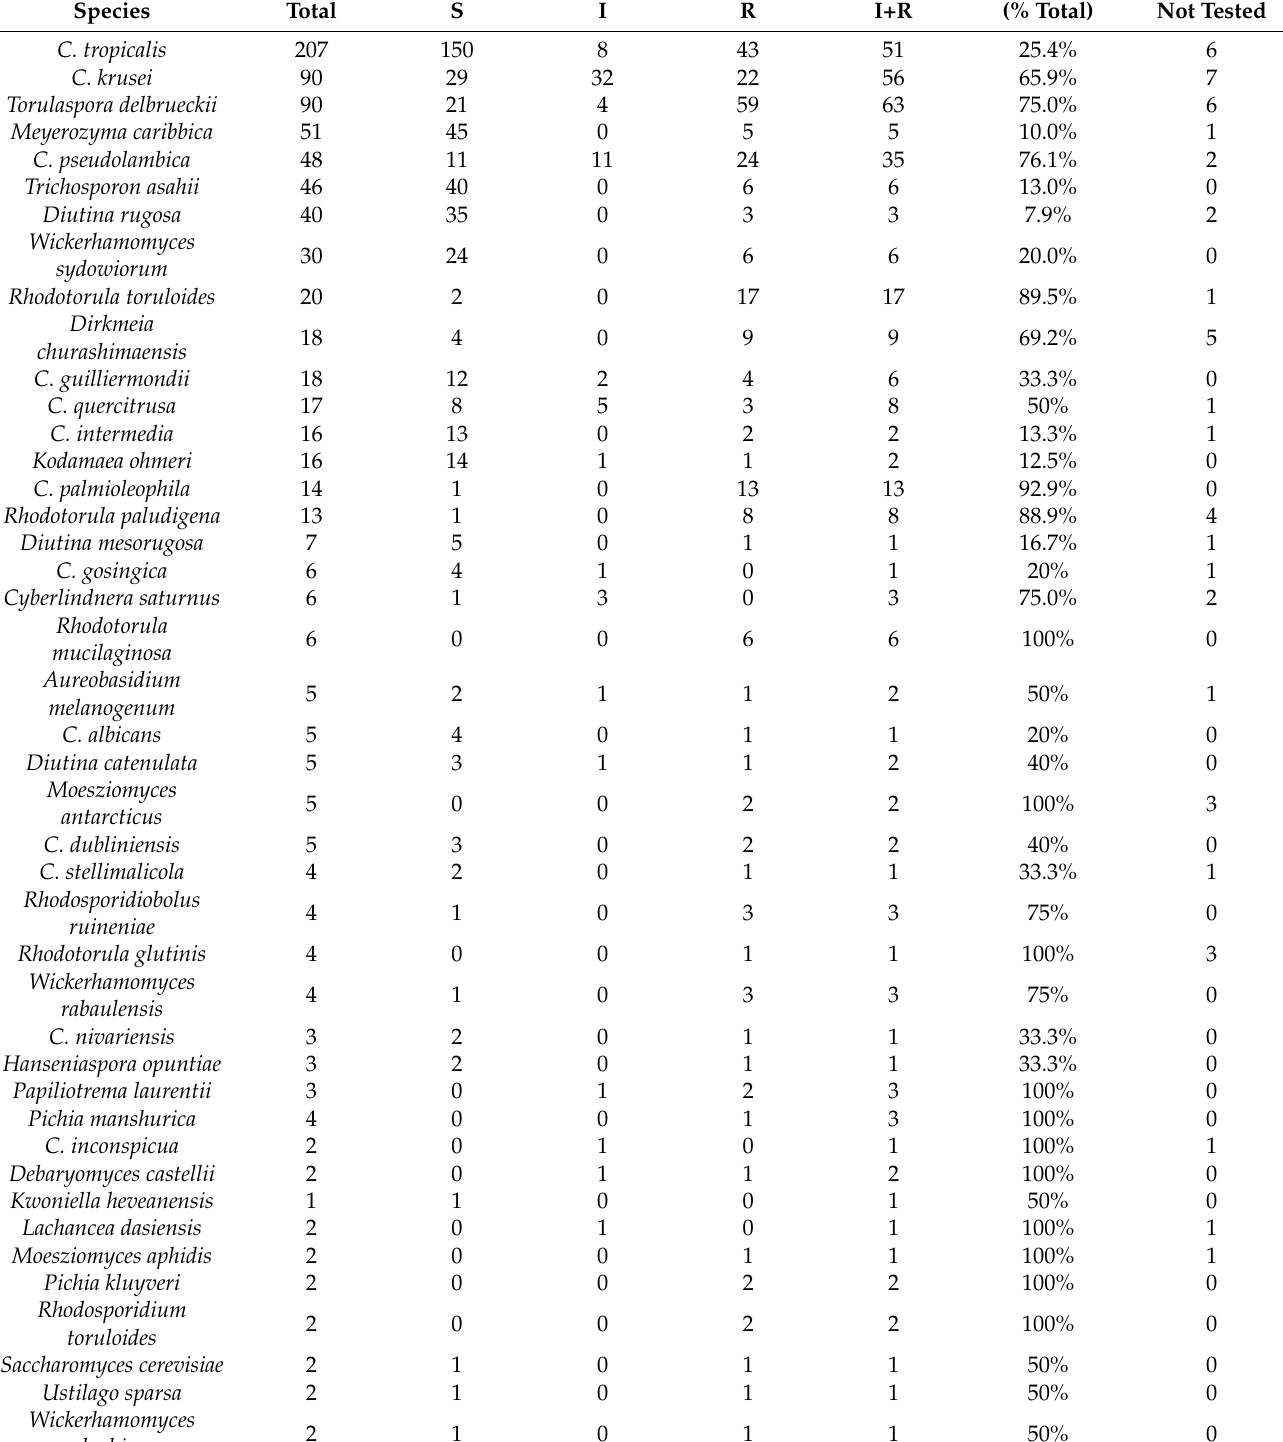
Table 2. Environmental yeast species with strains having fluconazole intermediate and/or resistance phenotypes as determined by CLSI M44-A2. S: susceptible; I: intermediate; R: